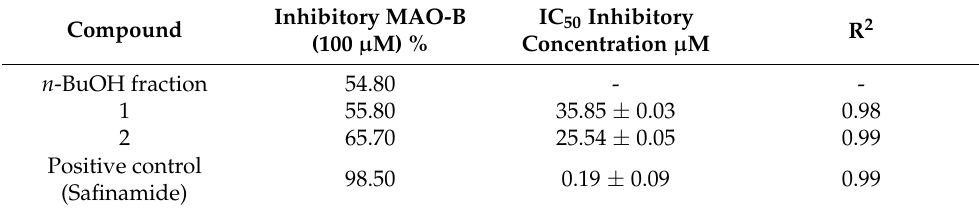
Table 1. Inhibitory effects of compounds 1 and 2 on MAO-B.